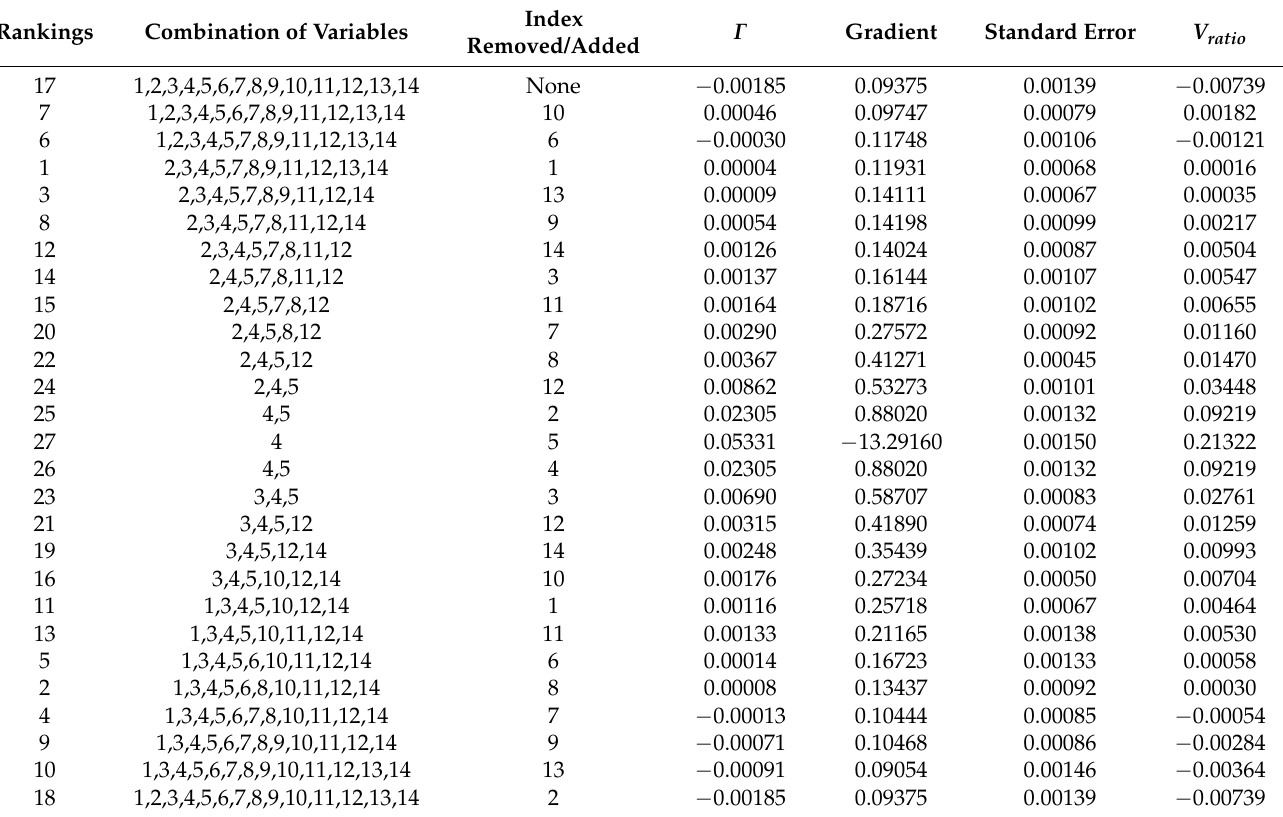
Table 3. Backward and forward selection of variables in the spatial dimension using the Gamma test.